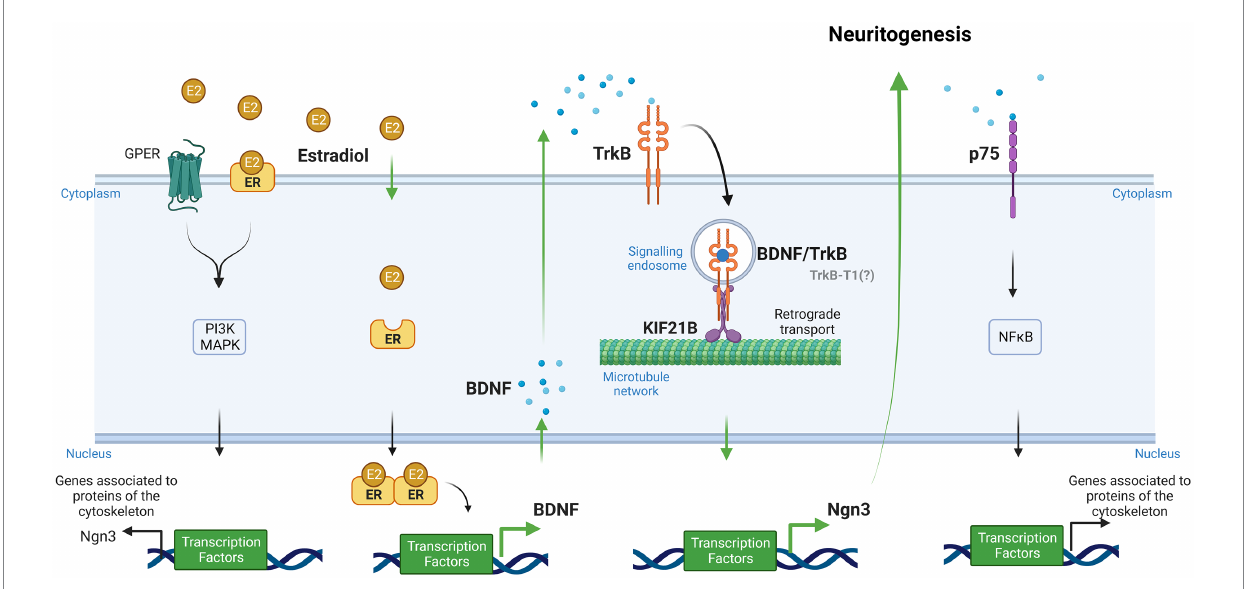
FIGURE 1 Signaling pathways implicated in the effect of estradiol on the differentiation and plasticity of hippocampal neurons (Created with BioRender.com). Neuroactive steroids and neurotrophins have similar functions in the brain due to their convergence at several points in their signaling pathways. One of these functions is neuritogenesis. Our study proposes a new signaling cascade by which estradiol modifies neuronal morphology. Estradiol increases brain-derived neurotrophic factor (BDNF) mRNA through an estrogen response element (ERE) via the canonical pathway. Neurons secrete endogenous BDNF, and this neurotrophin binds to the TrkB receptor forming the BDNF/TrkB complex. Cells endocyte this complex, and the kinesin KIF21B transports it retrogradely along the microtubule network. Ultimately, this leads to the expression of Ngn3, which regulates neuritogenesis. Additionally, estradiol can activate other signaling pathways, namely, PI3K and MAPK, by binding to GPER and membrane receptors, leading to the transcription of genes associated with cytoskeleton proteins. BDNF also can bind to its low-affinity receptor p75, which activates NF κ B and regulates molecular cascades that change genes related to cytoskeleton modifications (Green arrows show the steps taken to test the hypothesis proposed by our study to explain the implication of Kif21B in the effect of estradiol. Black arrows show data reported in previous